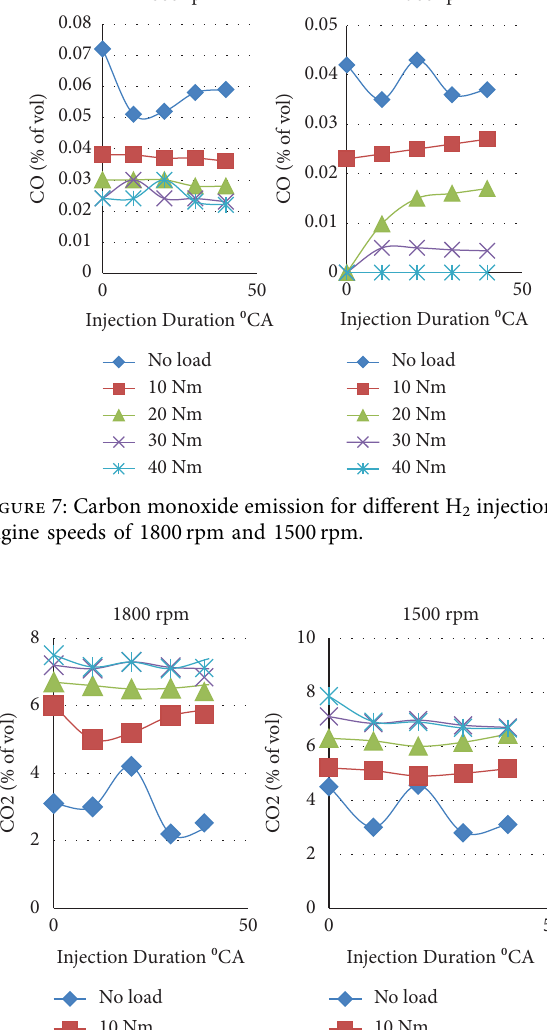
2 injection of engine